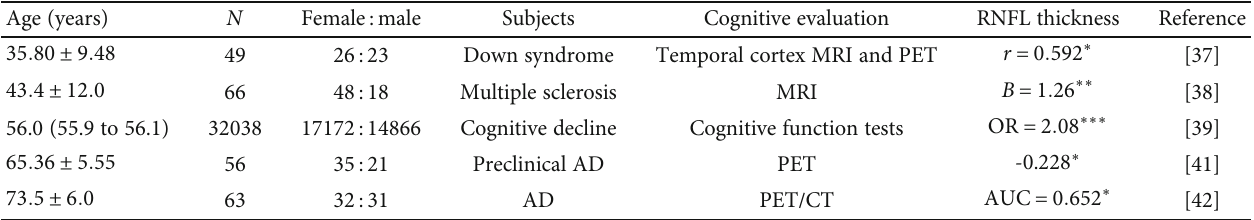
Figure 4: Correlations of the A β level in the cerebrum and retina of APP transgenic mice with (b) and without (a) administration of curcumin. Abbreviations: APP: APPswe/PS1dE9. Table 1: RNFL thickness inpatients of di ff erent ages with neurodegenerative